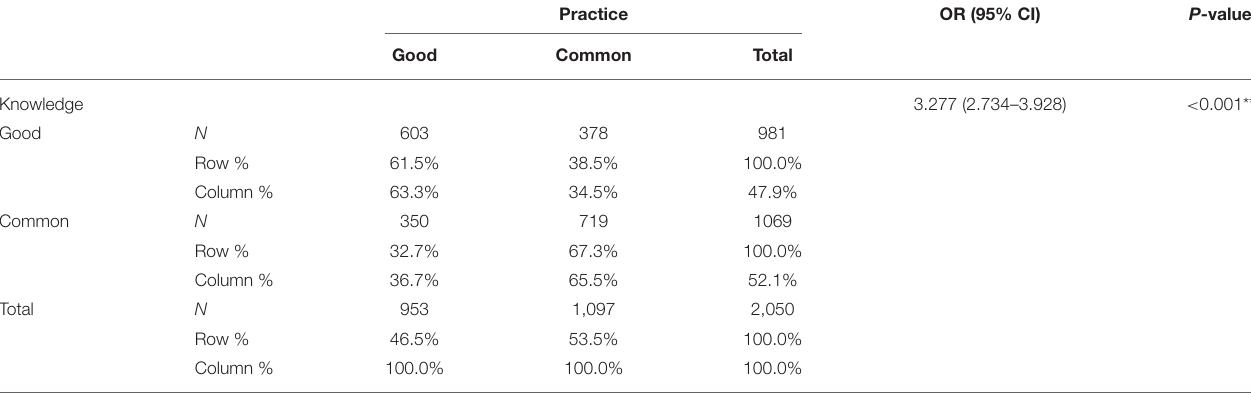
TABLE 4 | Cross-table of knowledge and practice of COVID-19 prevention measures ( N = 2,305).